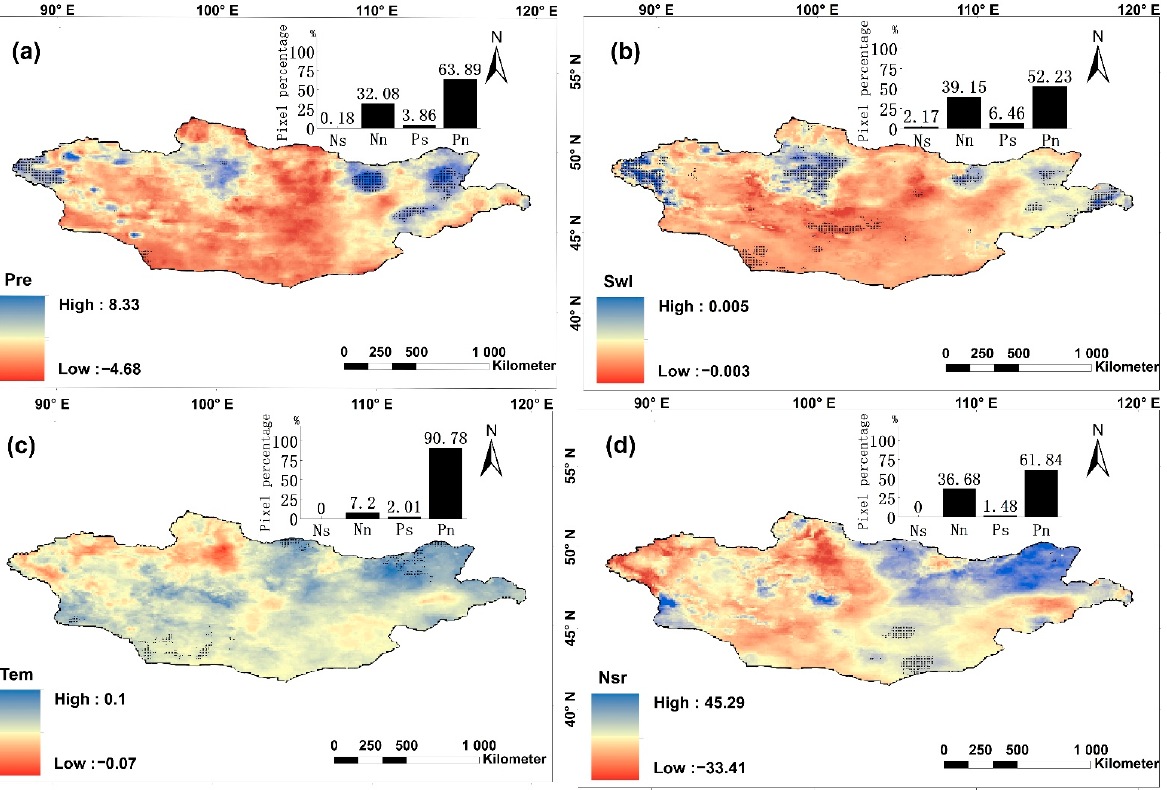
Figure 2. Spatial trends of the annual average values of ET and natural factors in Mongolia from 2001 to 2020. Black dots indicate significant changes ( p < 0.05). The inset histograms display the percentages of Pn (not significantly positive), Ps (significantly positive), Ns (significantly negative) and Nn (not significantly negative) values. Precipitation ( a ); soil moisture ( b ); temperature ( c ); Net